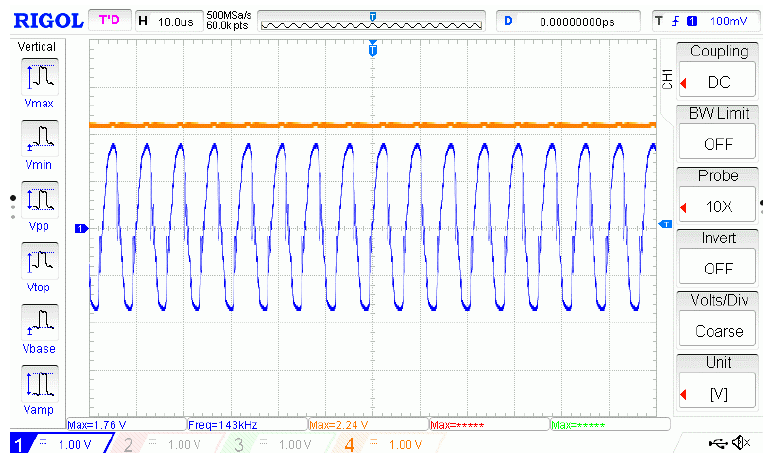
Figure 15. Receiving side voltage waveforms; blue curve (CH_1) presents the receiving coil voltage, orange curve (CH_4) presents the signal of the voltage multiplier circuit.